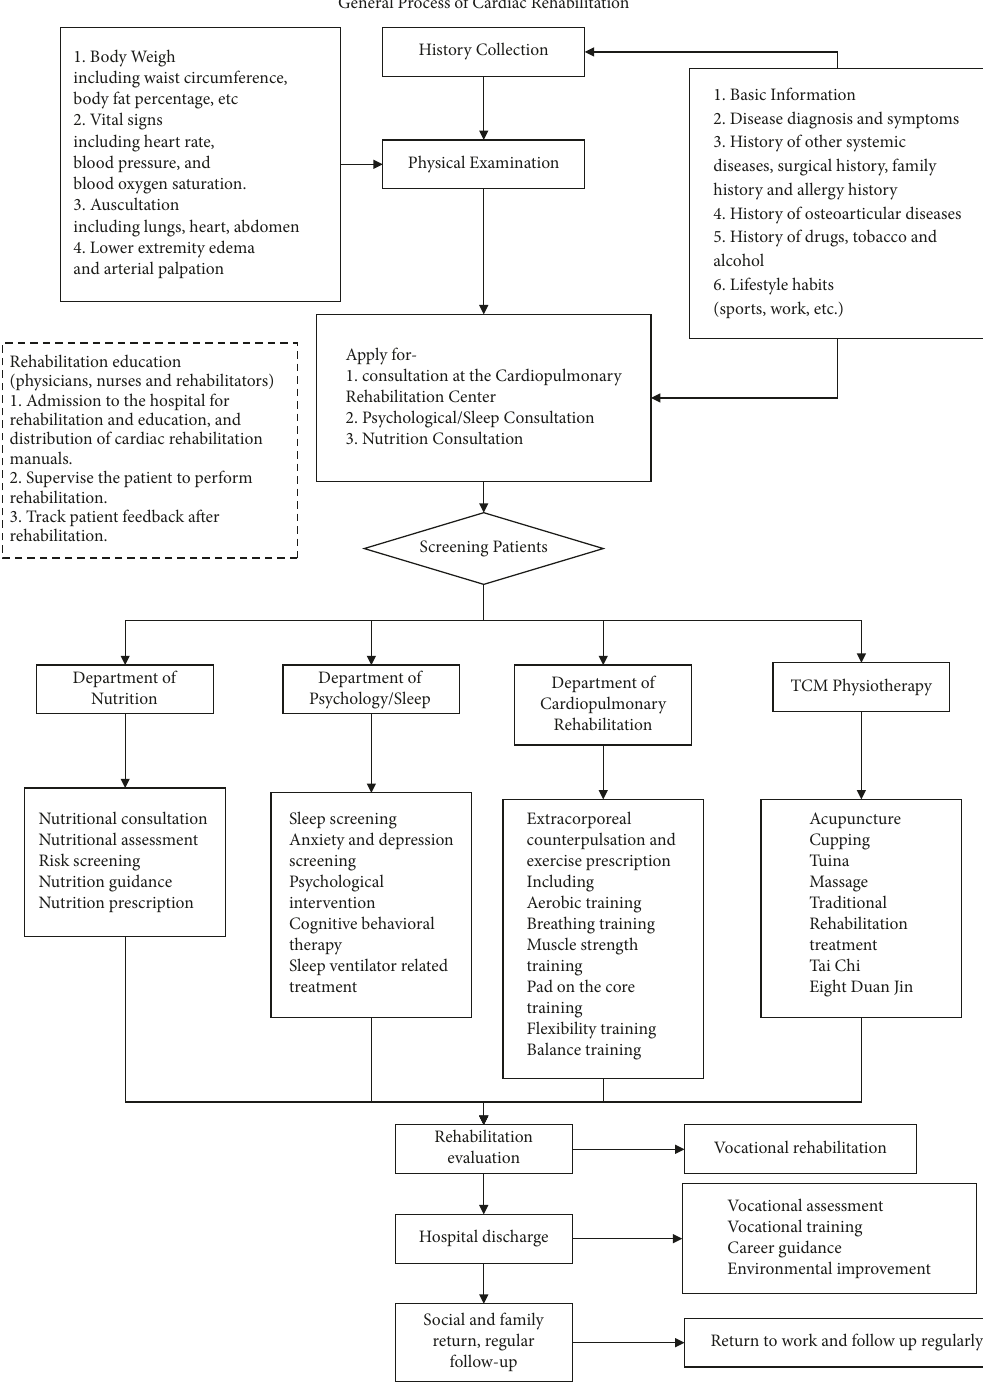
Figure 1: General process of cardiac rehabilitation. The flowchart summarized the standard procedure of cardiac rehabilitation for patients in